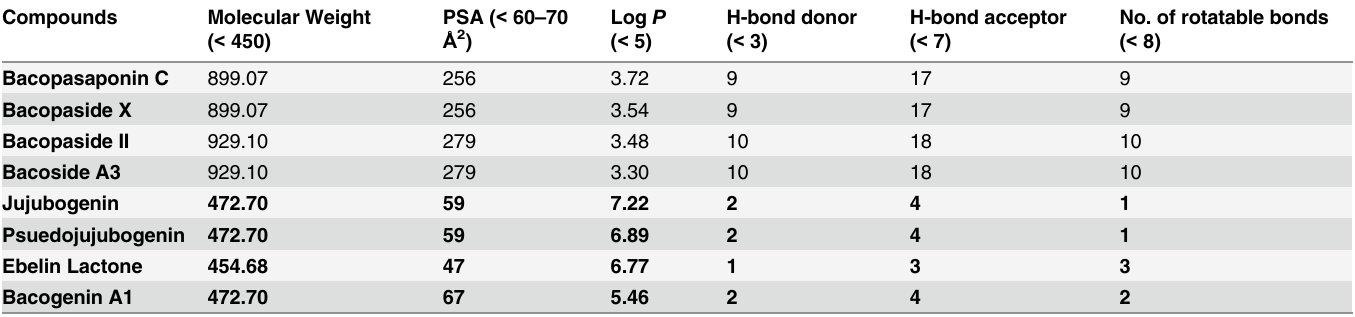
Table 3. The physicochemical properties of bacopasaponin C, bacopaside X, bacopaside II, bacoside A3, jujubogenin, pseudojujubogenin, ebelin lactone and bacogenin A1.